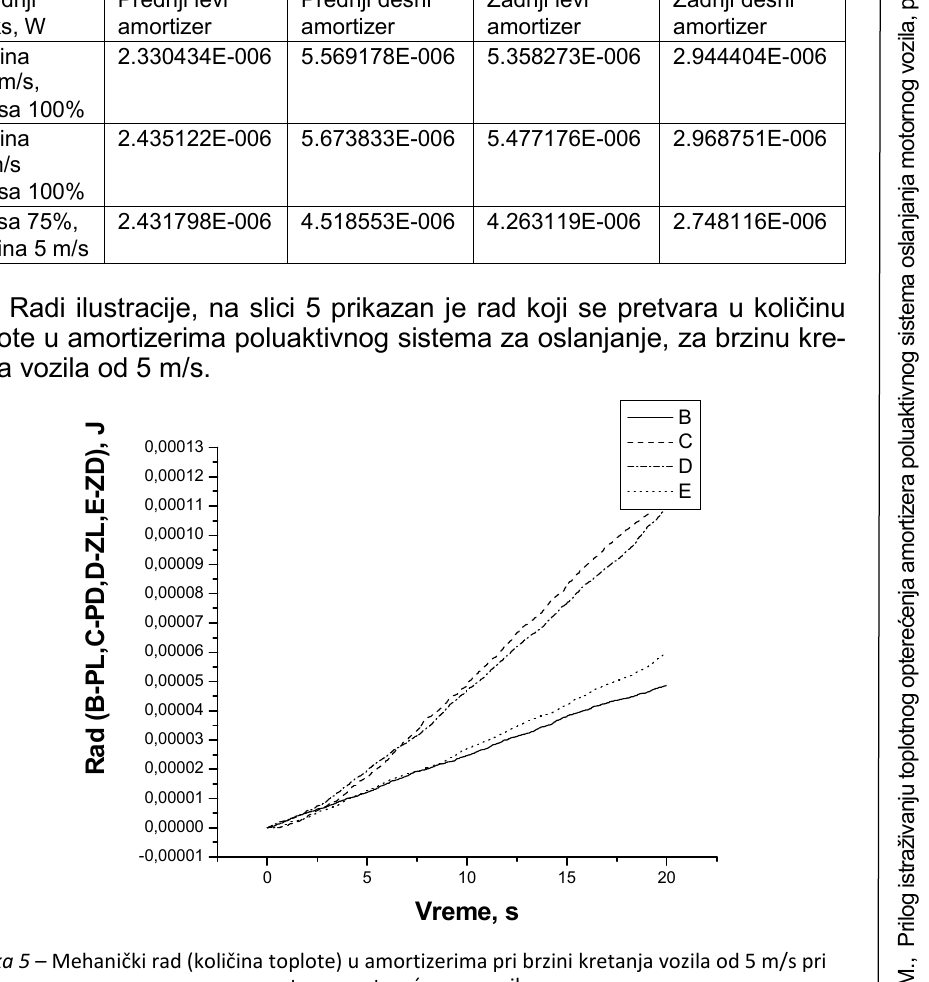
potpuno optere ć enom vozilu Figure 5 – Mechanical work (the heat amount) in shock absorbers for a speed of 5, m/s and a fully loaded